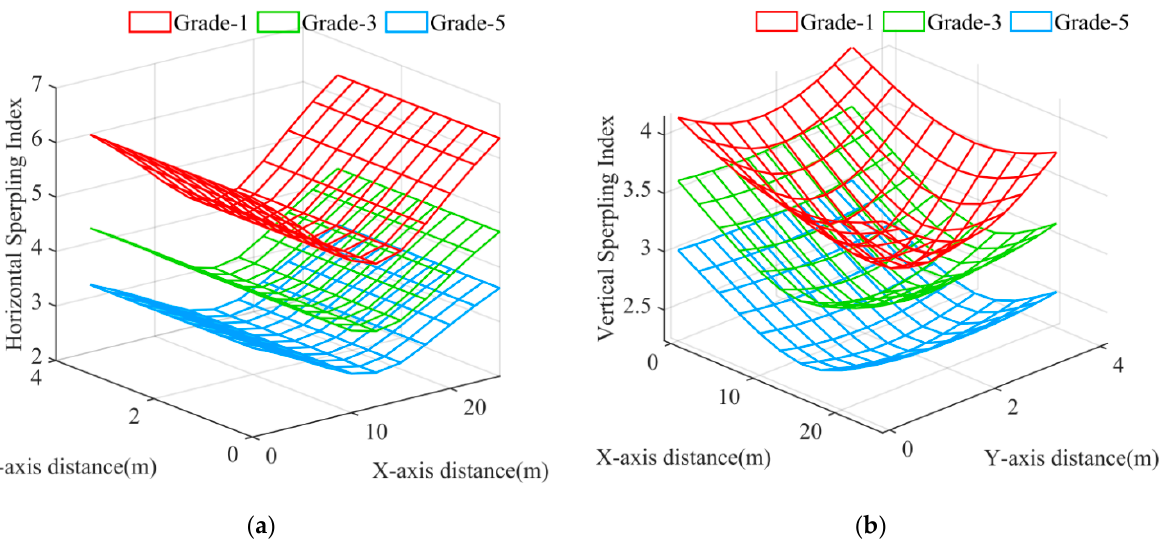
Figure 7. Zonal distribution of car-body Sperling index as influenced by the quality of the track irregularities using PEM: ( a ) horizontal Sperling index; ( b ) vertical Sperling index.